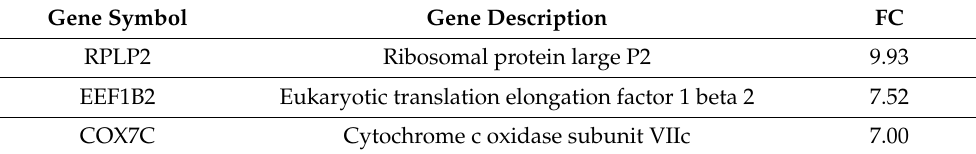
Table 4. Gene symbol, gene description, and logarithm of fold change (FC) of differentially expressed (upregulated) genes between cd26-siRNA-injected and non-injected porcine blastocysts. Gene